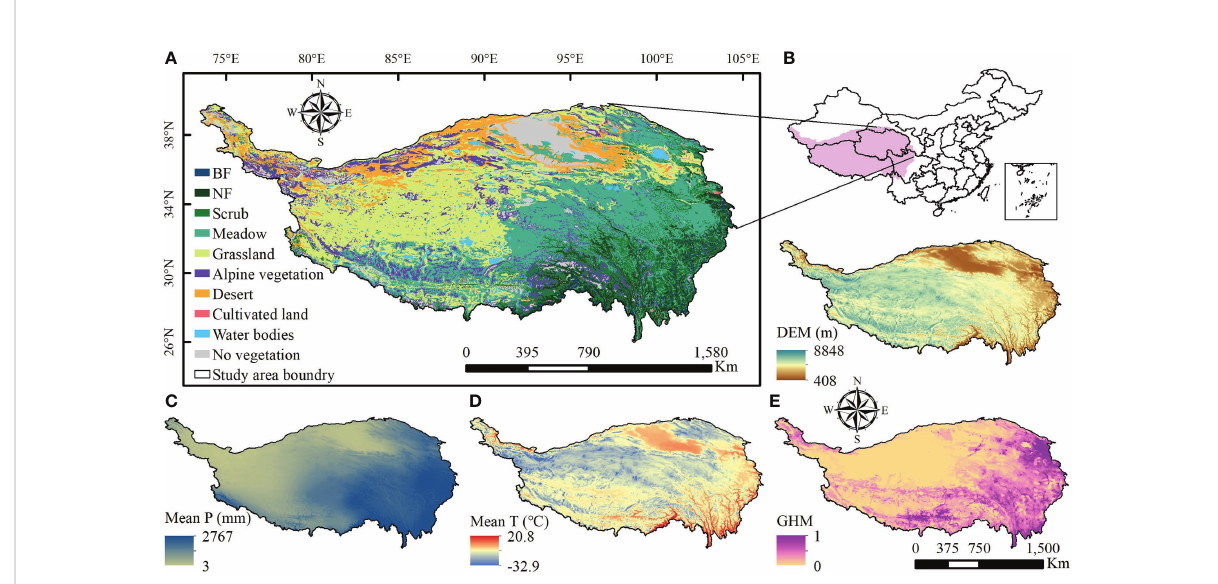
FIGURE 1 Spatial distribution of vegetation types, topographic and climatic variables, and human activity intensity on the Qinghai-Tibetan Plateau. BF is the broadleaf forest and NF is the needle-leaf forest in (A) ; in (B) , the digital elevation model (DEM) shows elevation of the QTP; in (C) , Mean P means mean annual total precipitation from 2000 to 2020; in (D) , Mean T represents the mean annual average temperature from 2000 to 2020; and GHM represents the Global Human Modi fi cation Index in (E) , characterizing the intensity of human activities.